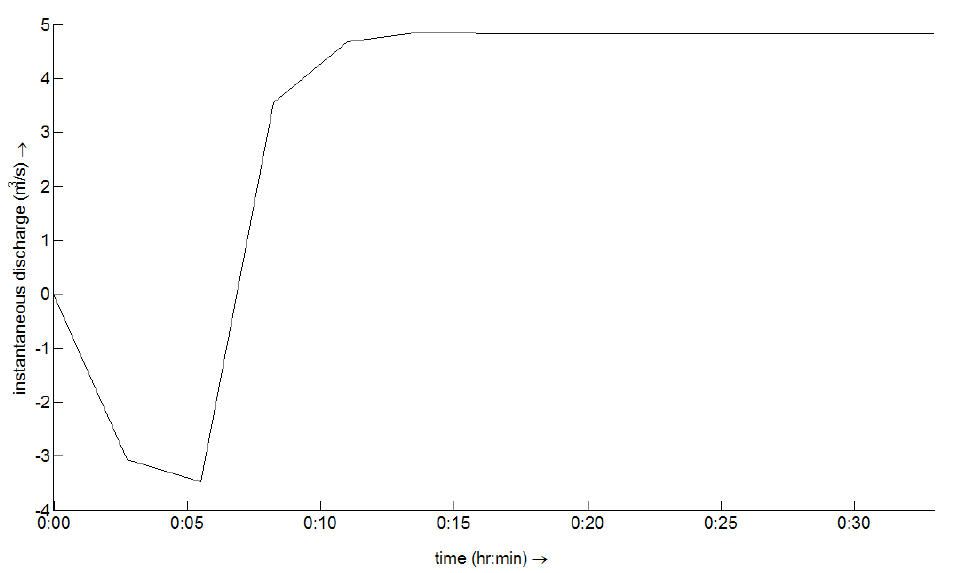
Figure 15. Instantaneous discharge vs. time across C-S EF for HDS